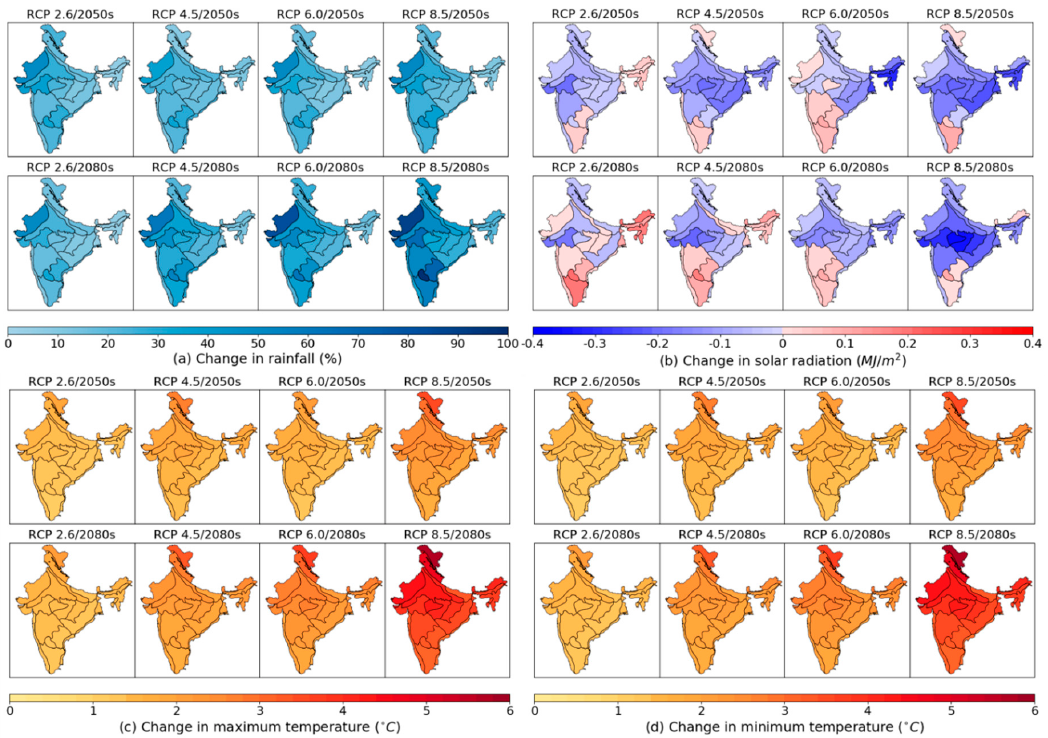
Figure 6. Climate change analyzed based on annual mean changes in ( a ) rainfall, ( b ) solar radiation, ( c ) maximum, and ( d ) minimum temperature with respect to 1990s for two future periods—2050s and 2080s and all the representative concentration pathways (RCP) scenarios.